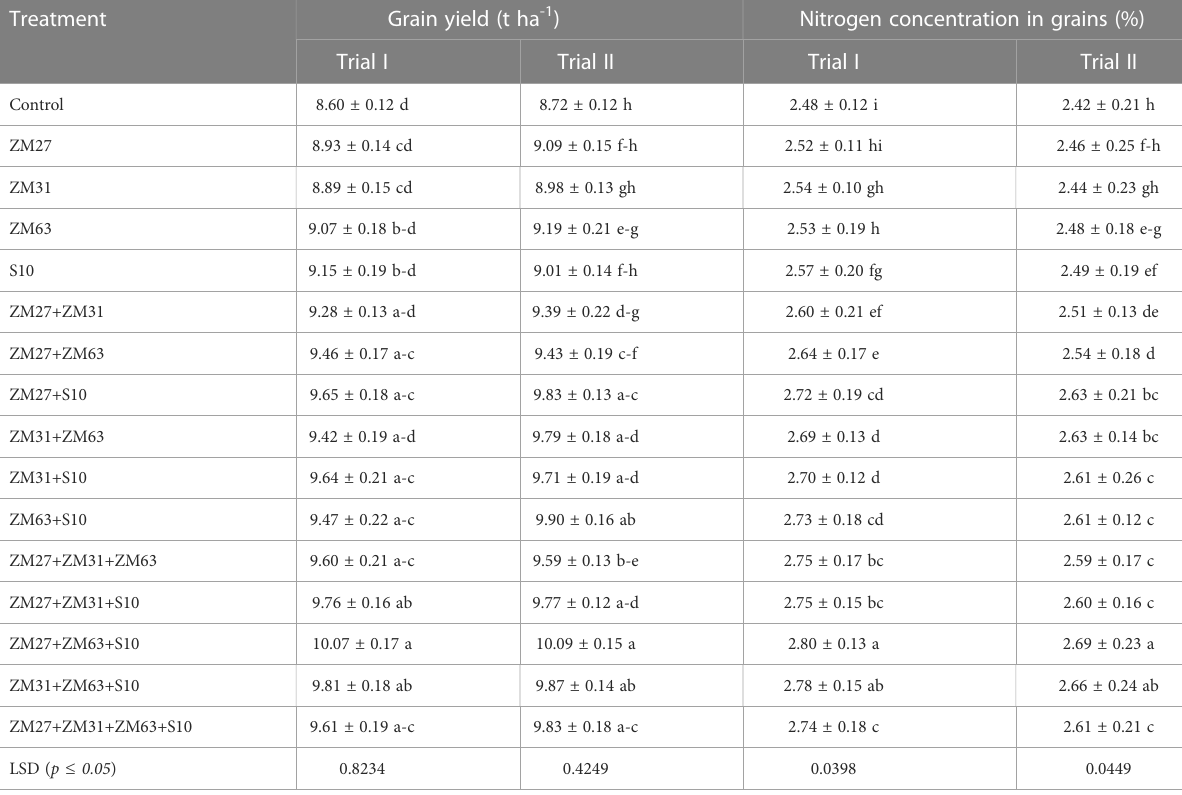
TABLE 6 Effect of novel bio inoculants on Grain yield and N contents of Maize in fi eld trial.